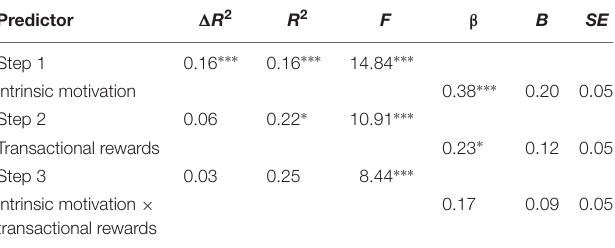
TABLE 5 | Hierarchical regression analysis predicting creativity/innovation from intrinsic motivation and transactional rewards.